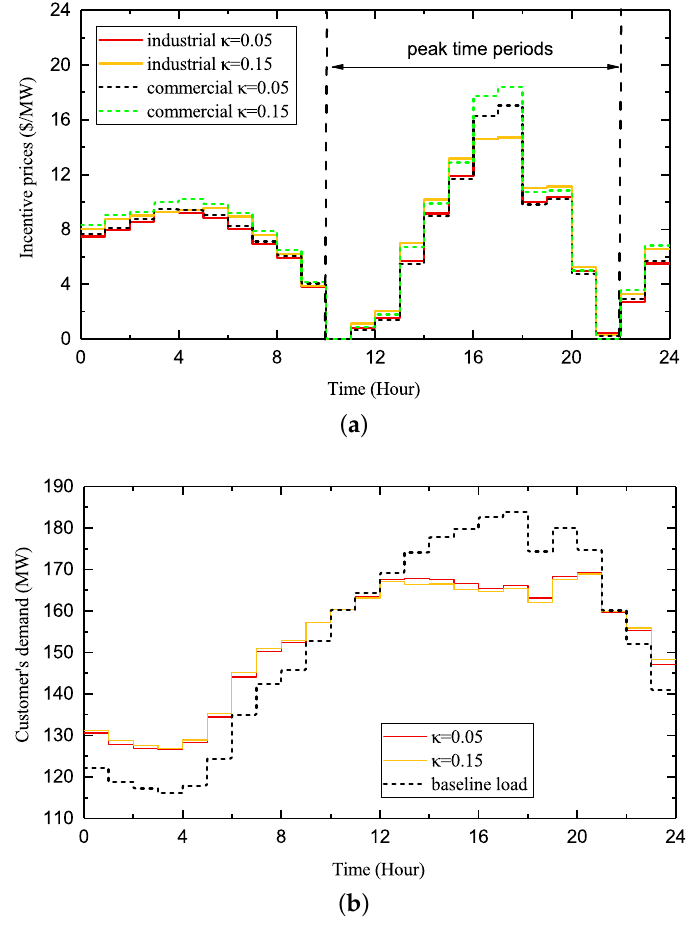
Figure 7. ( a ) SL incentive prices under different κ ( b ) Customers’ demand under different κ . Table 6. SL incentive payments of the retailer and the amount of customers’shifted load under different κ . κ = 0.05 κ = 0.075 κ = 0.1 κ = 0.125 κ = 0.15 SL incentive payments ($)